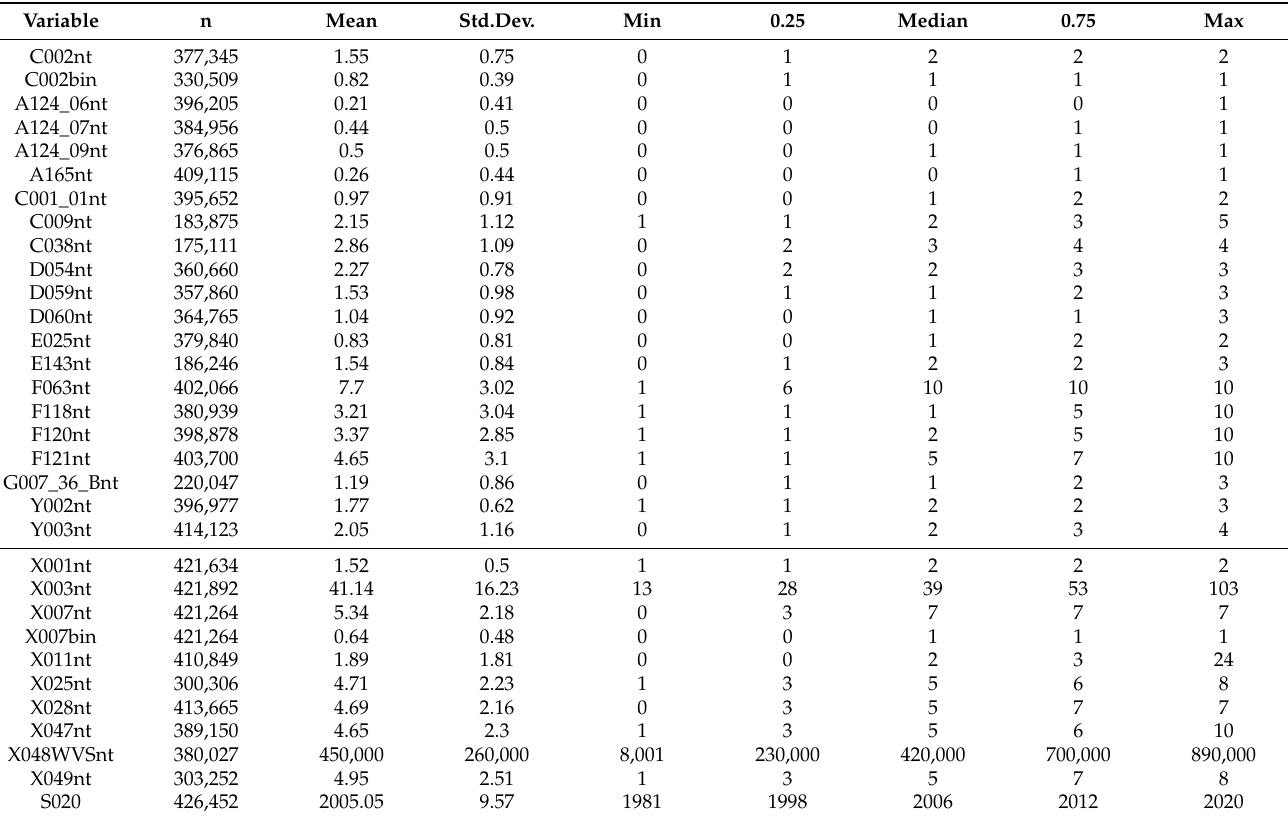
Table A2. Descriptive statistics for the most relevant WVS items used in this